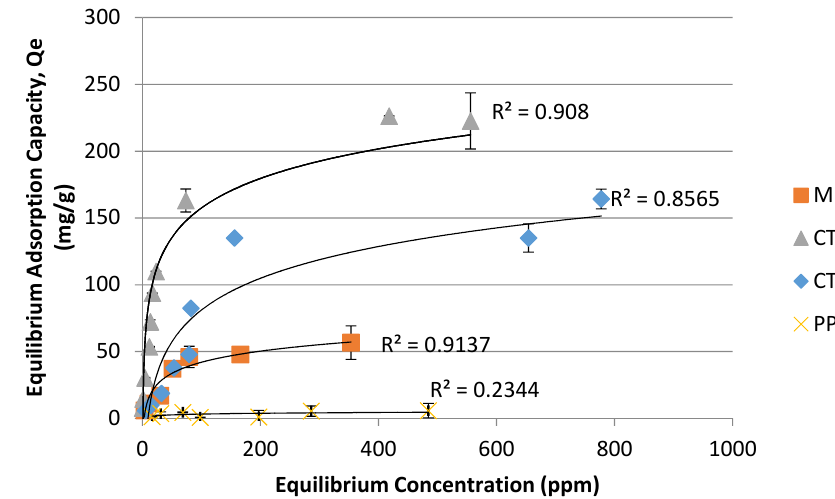
Figure 9. Adsorption isotherm. Table 1. Langmuir and Freundlich Isotherm constants.